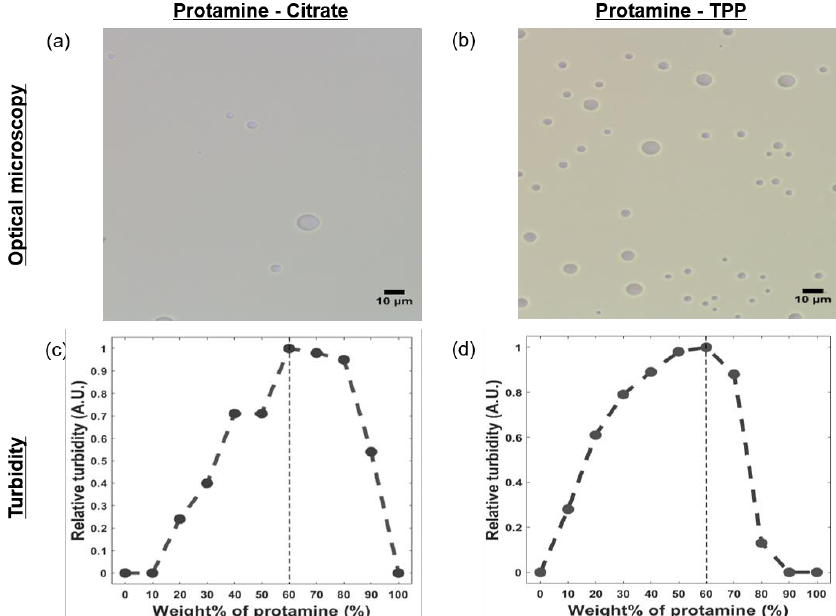
Figure 2. Optical microscopy image of ( a ) protamine / citrate coacervate obtained at pH 8.0 and ( b ) protamine / tripolyphosphate (TPP) coacervate at pH 4.5. The total polyelectrolyte concentration ( C p ) was 1% ( w / v ), and the scale bar is 10 µ m. The optical turbidity of ( c ) protamine / citrate coacervates and ( d ) protamine/TPP coacervates with different weight ratios. C p was 0.1% ( w / v ).